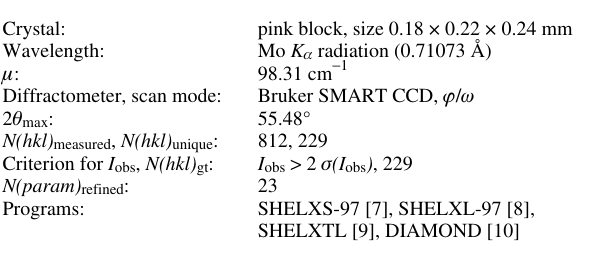
Table 1. Data collection and handling.